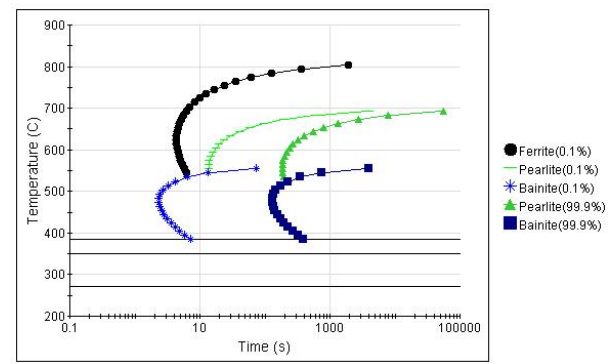
Figure 1. Time-temperature-transformation (TTT) diagram of the test steel.